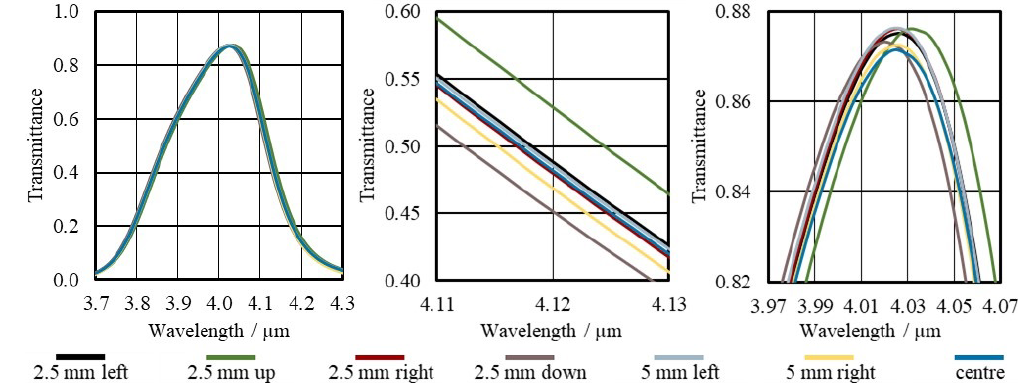
Figure 7. Filter transmittance measured with FTS of a filter with its bandpass at about 4µm at different local positions on the filter for evaluation of the local inhomogeneity of the spectral transmittance. Shown is the same measurement in different wavelength extracts.